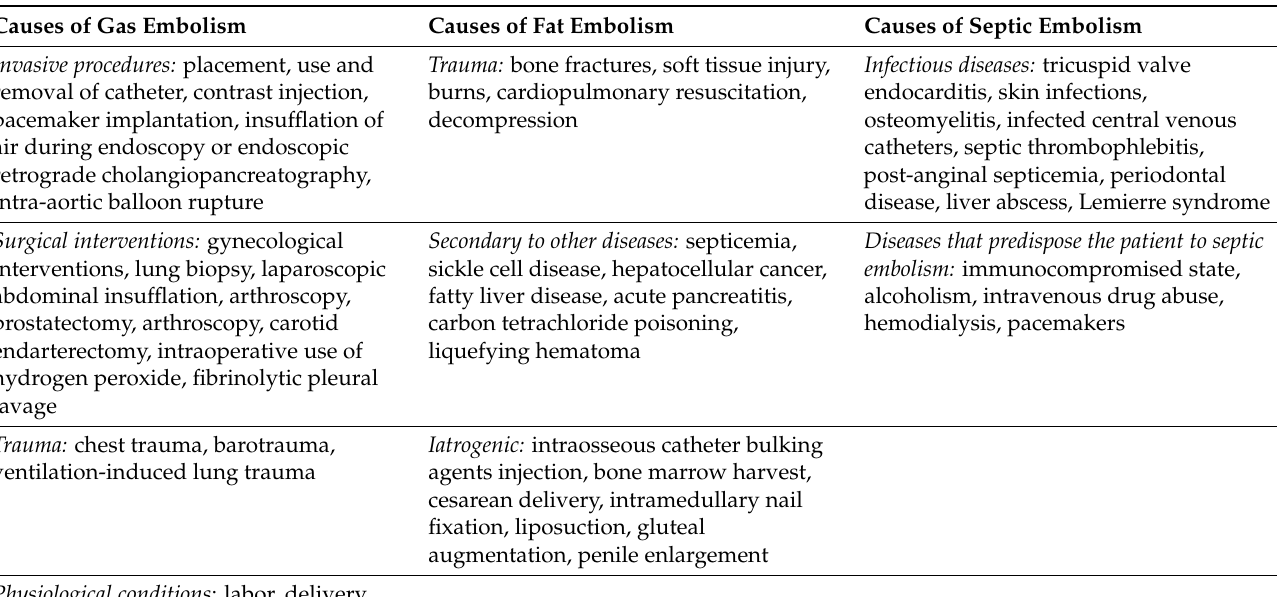
Table 3. Causes of nontrombotic pulmonary